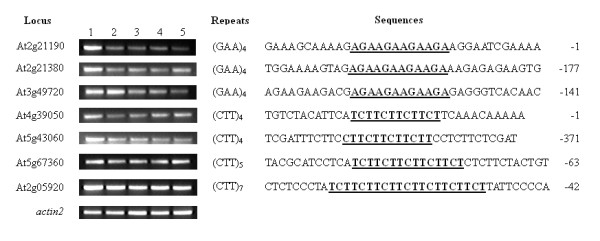
Expression patterns of Arabidopsis CNMS (CTT)n/(GAA)n associated genes and their related sequence information. The expression of genes were assayed by RT-PCR. Lanes 1–5: control (untreated), 1, 4, 12 and 48 hours after treatment with 1 mM salicylic acid, respectively. The actin2 gene was used as an internal control in the RT-PCR reaction.